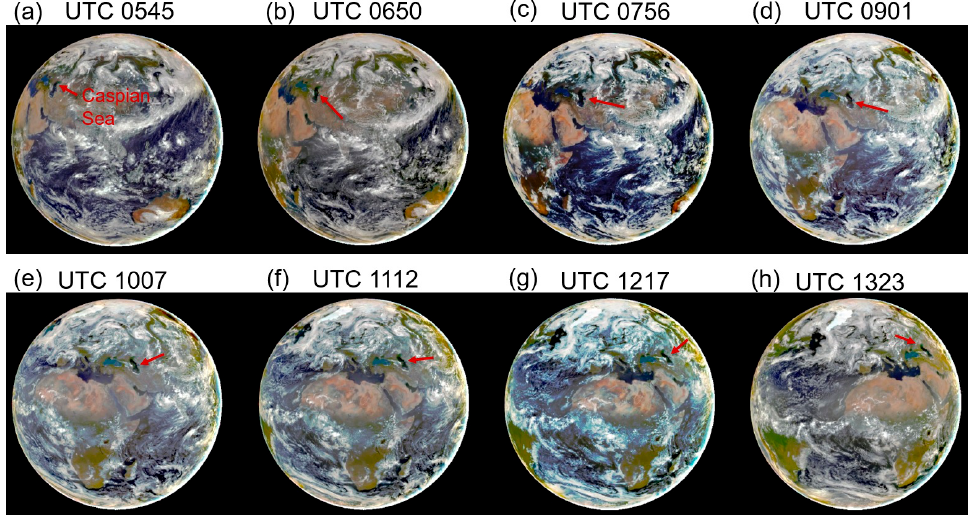
Figure 5. ( a )–( h ) Eight sunlit full disk color images processed from atmosphere corrected EPIC channel (Red: 680 nm; Green: 551 nm; Blue: 443 nm) images acquired on 26 June 2017 at UTC 0545, 0650, 0756, 0901, 1007, 1112, 1217, and 1323, respectively. The spatial locations of the Caspian Sea in these images are pointed to with red arrows.